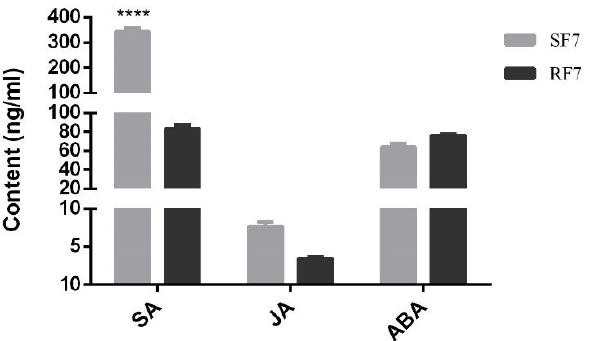
Figure 4. Comparison analysis of SA, JA, and ABA contents in different samples. SF7, Susceptible cultivar + FON, 7 days post inoculation (7 dpi); RF7, Resistant cultivar + FON, 7 days post inoculation (7 dpi). Data were expressed as mean ± SE ( n = 3). Multiple t-test of Two-way ANOVA (****, p ≤ 0.0 001).